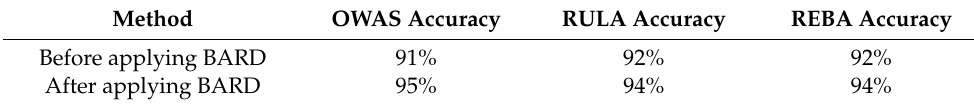
Table 6. Evaluation and comparison of accuracy of good posture for validation datasets.